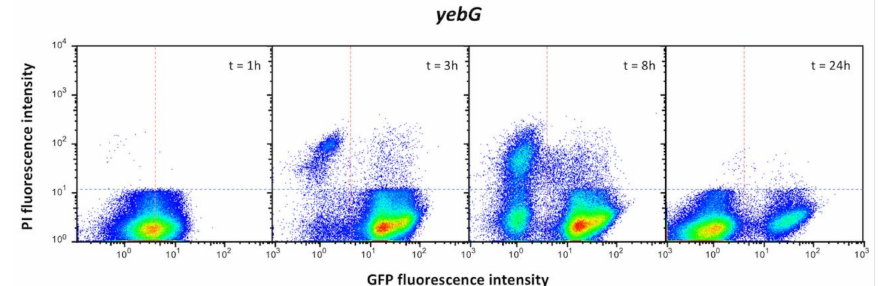
Figure 9. Single cell analysis of live and dead YebG OFF and YebG ON subpopulations after addition of nalidixic acid. The vertical division sorts OFF (GFP − , left) and ON (GFP + , right) subpopulations. The horizontal division sorts live (PI − , bottom) and dead (PI + , top)